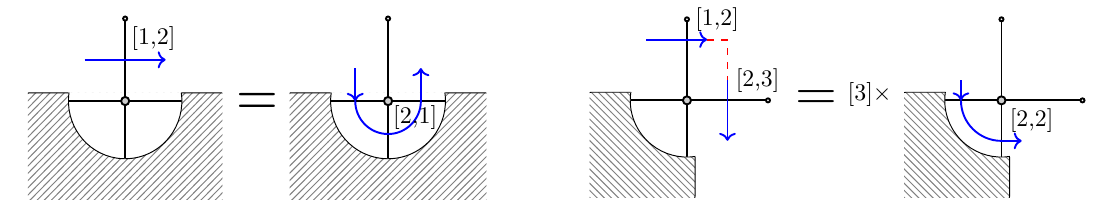
Figure 9 . Local transformations of the monodromy contour. The dashed part represents the rest of the graph which is not touched by the current transformation. Pushing the contour inside the graph involves integrations by parts. If the initial monodromy acts on an L -loop graph, then, after one local transformation, the new monodromy (transformed contour) acts on the ( L